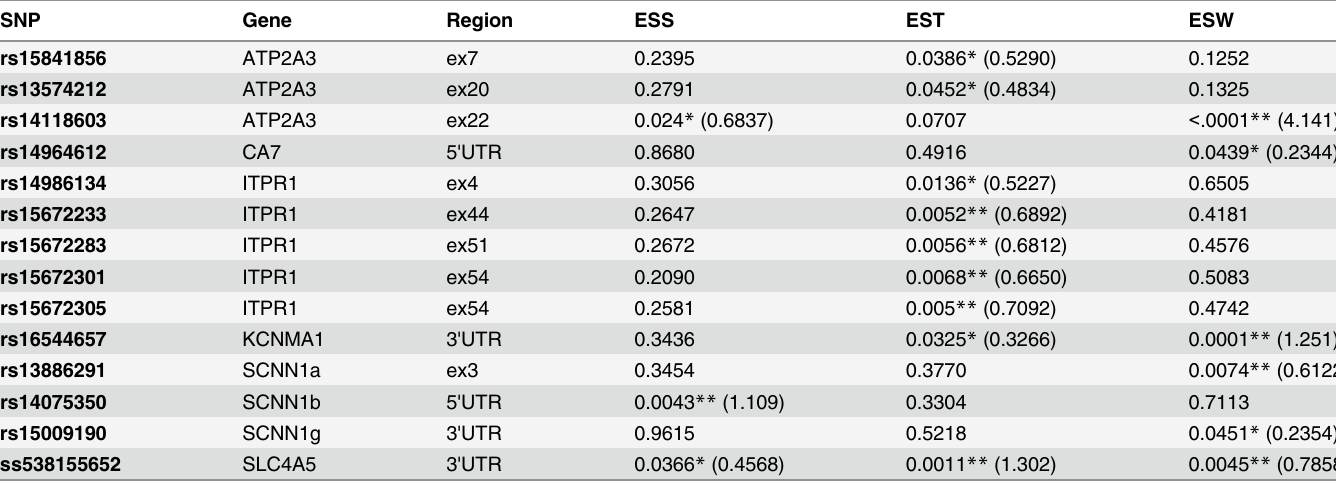
Table 4. Association analysis of the SNPs with eggshell mechanical property traits a,b,c